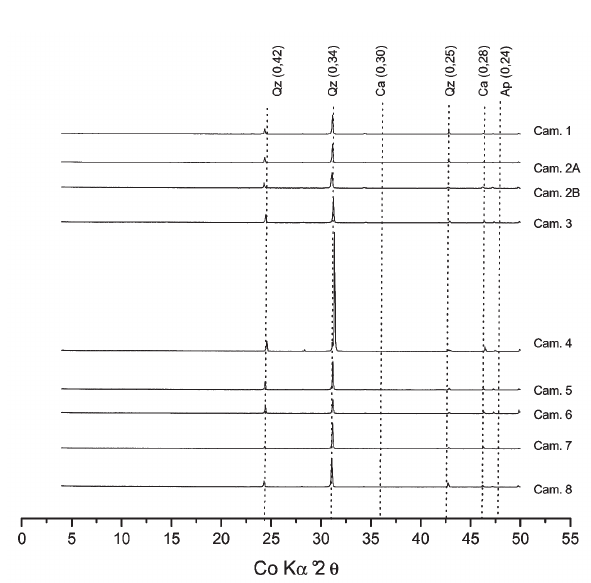
Figura 7. Difratogramas de raios-X da fração areia do solo da Lapa do Malhador. Qz: quartzo; mica; Ct: caulinita; Ca: calcita; e Ap: apatita.